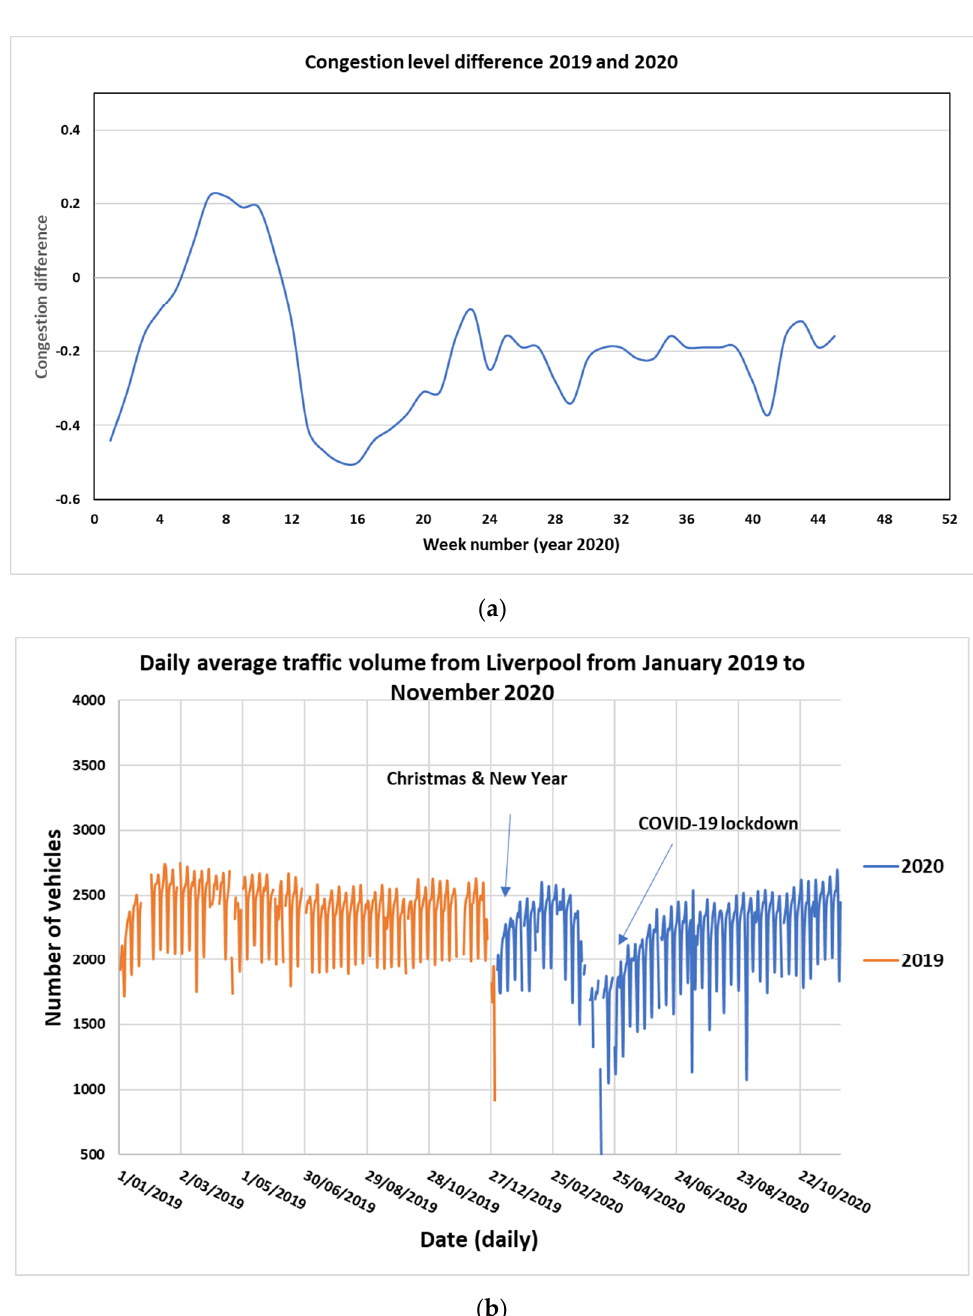
Figure 1. Congestion level relative difference between 2019 and 2020 (difference greater than the standard weekly congestion level in 2019) ( a ) (source: Tomtom traffic flow https://www.tomtom.com/en_gb/traffic-index/sydney-traffic/. Accessed on 19 March 2021) and daily number of vehicles on Liverpool Road as counted at a traffic site from January 2019 to November 2020 ( b ) (source: NSW Road and Maritime Services, RMS).